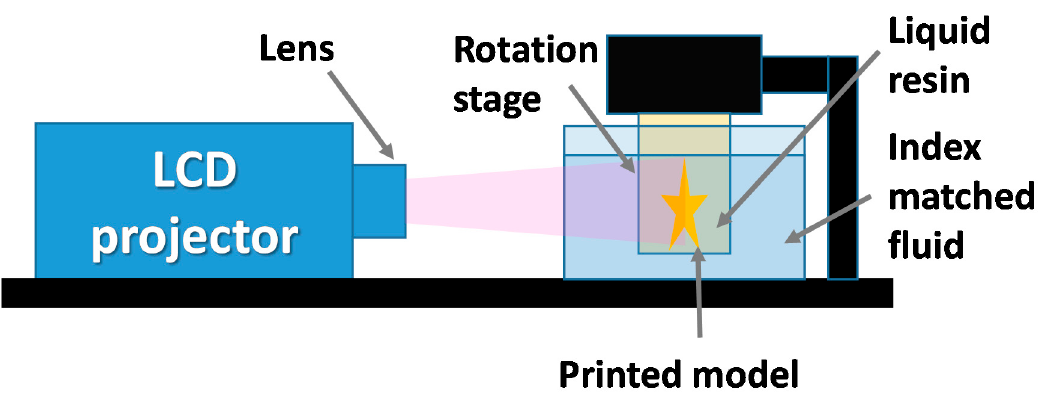
Figure 8. Computer axial lithography setup.